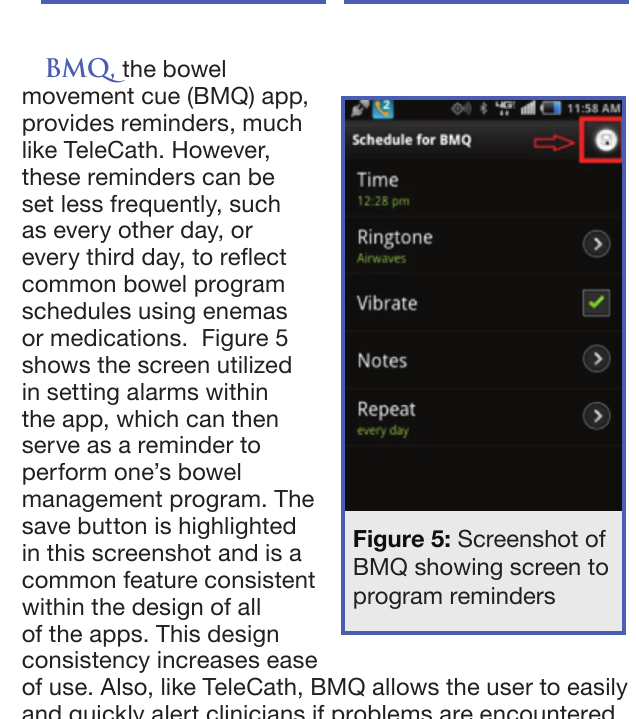
Figure 5: Screenshot of BMQ showing screen